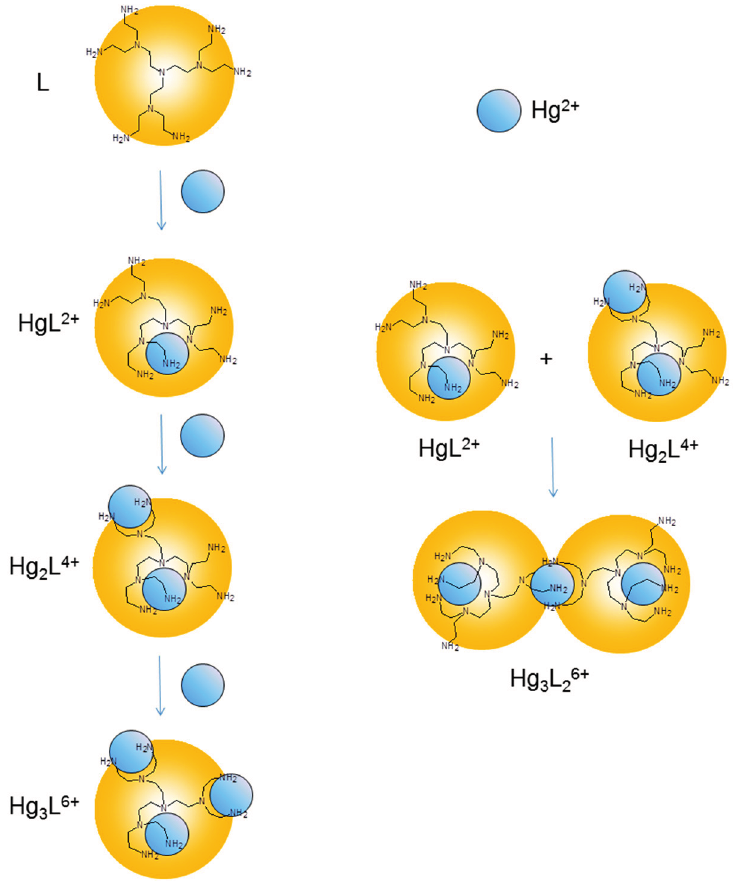
Figure 3. Schematic representation of the coordination environments suggested for the Hg(II) complexes formed by L in